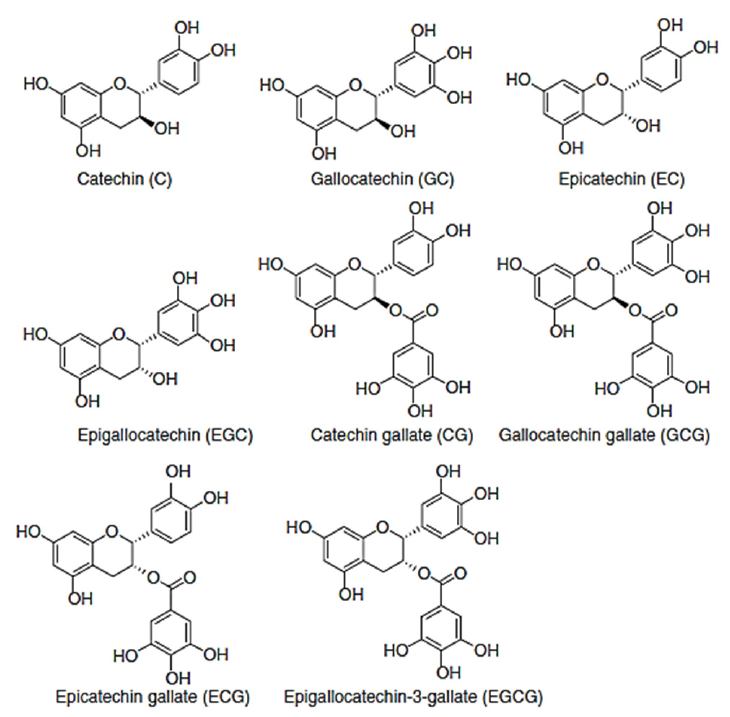
Figure 5. Structures of monomeric flavan-3-ols.